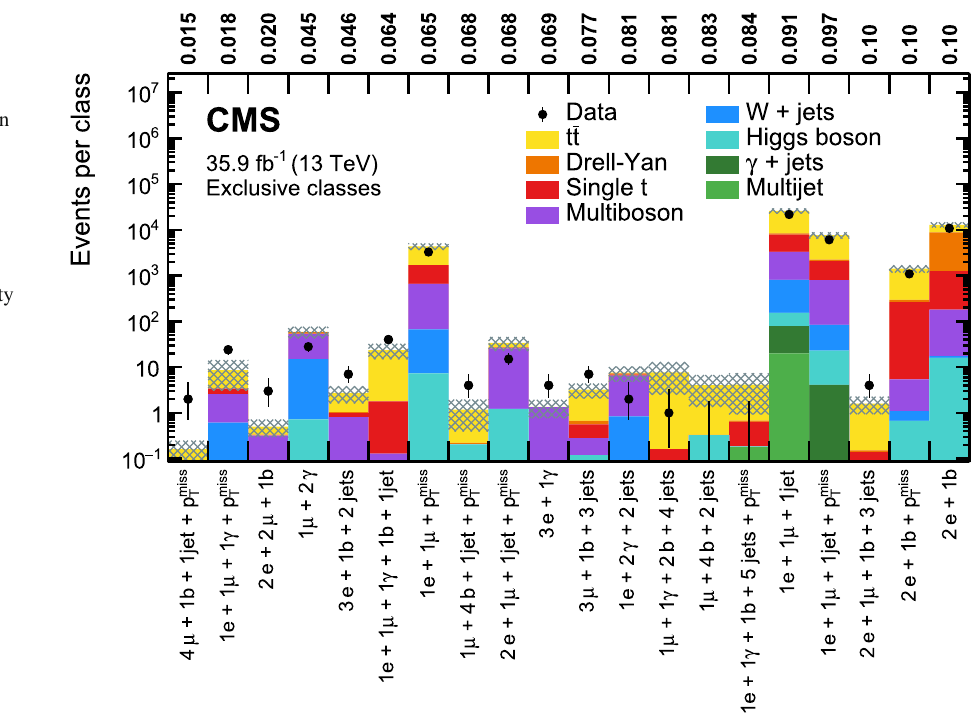
Fig. 8 Data and SM predictions for the most significant exclusive event classes, where the significance of an event class is calculated in a single aggregated bin. Measured data are shown as black markers, contributions from SM processes are represented by coloured histograms, and the shaded region represents the uncertainty in the SM background. The values above the plot indicate the observed p value for each event